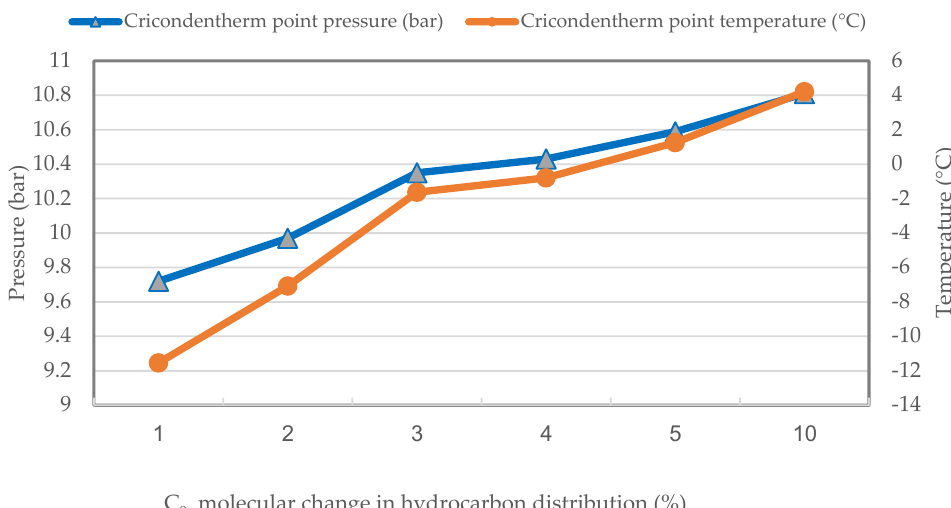
Figure 6. Results of C 9 – C 19 data analysis of Pendik RM-A natural gas station.